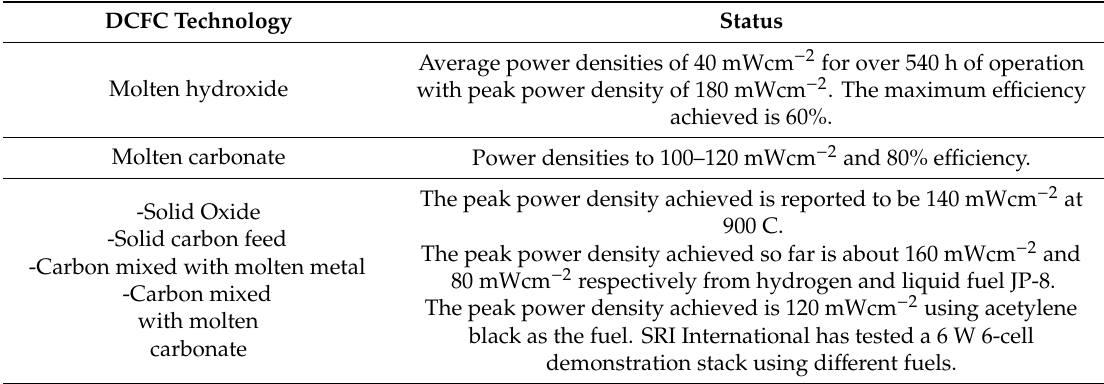
Table 2. Tecnology status of various types of direct carbon fuel cells